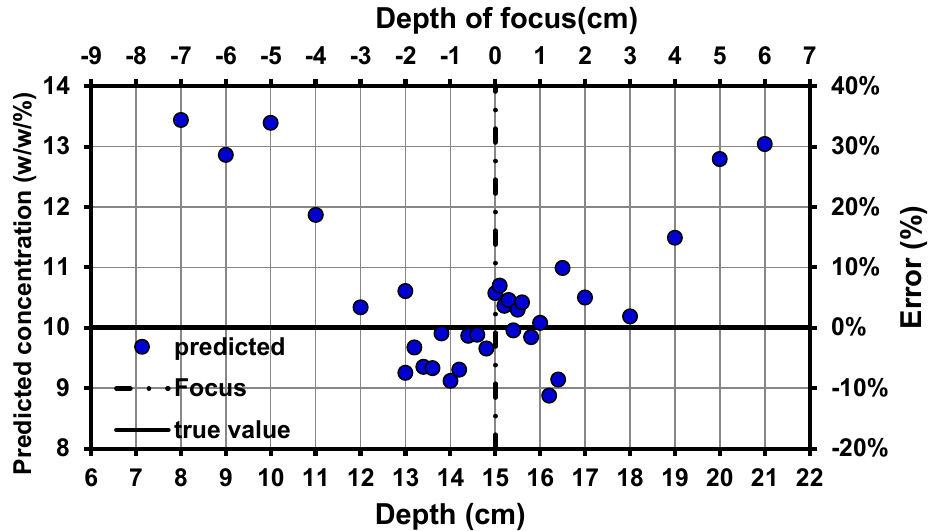
Figure 7. Variation in the percentage of error (%) and predicted concentration (%, w/w ) as a function